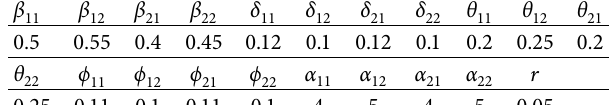
Table 1: The parameters used in the numerical example.